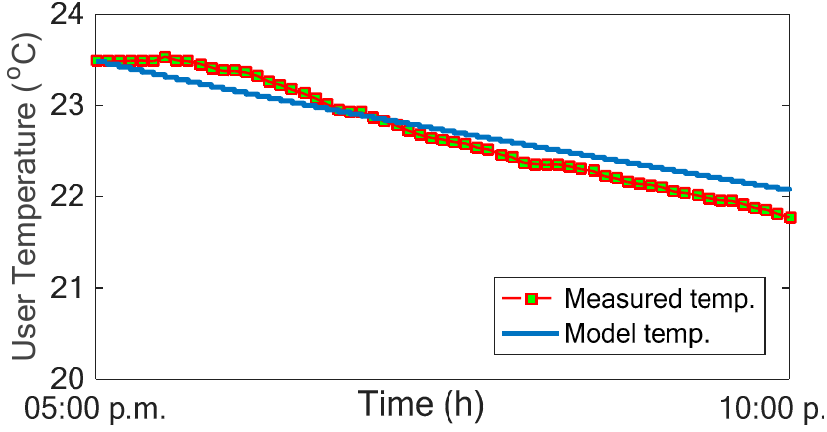
Figure 8. User temperature (V C 1 ) profile: measured data against model results from 5 p.m. to 10 p.m.